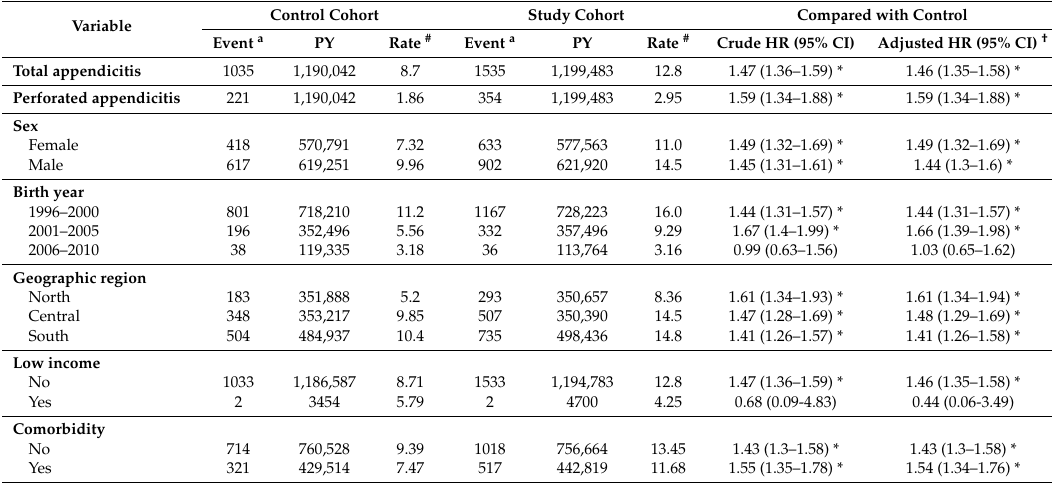
Table 3. Comparison of incidence and HR of appendicitis between study and control cohorts.